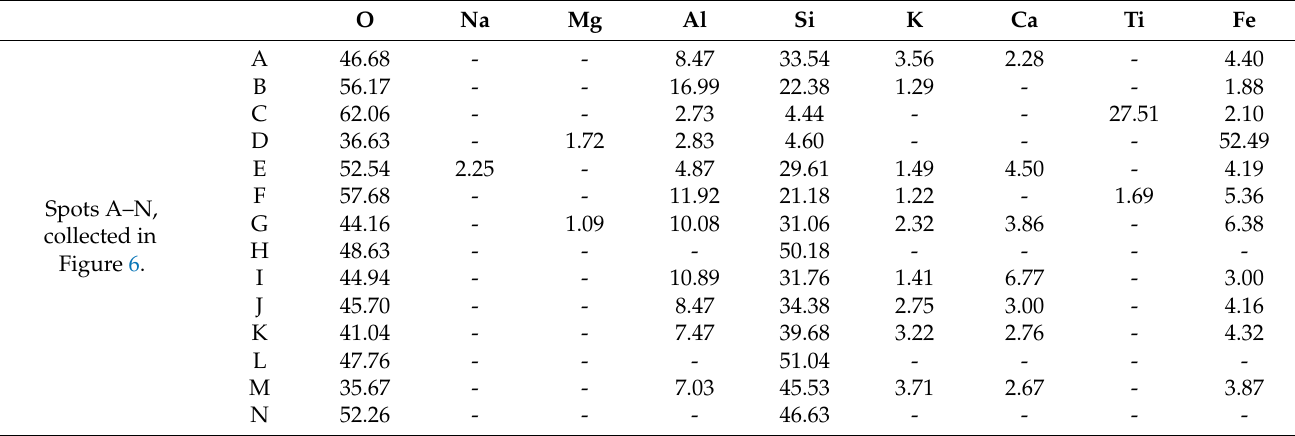
Table 2. EDS results for different regions collected at the glaze surface and cross-sections of